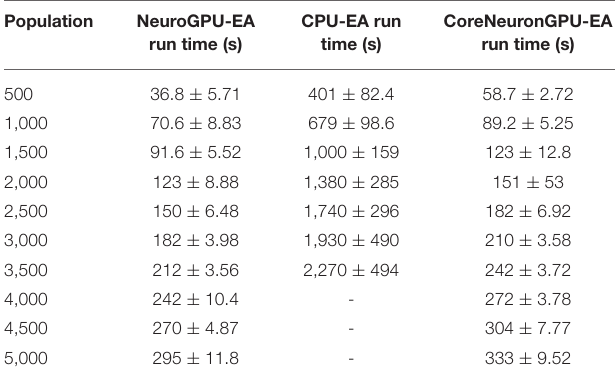
TABLE 1 | Compute fixed and problem scales: Stimuli and score functions are fixed 8 and 20, respectively.